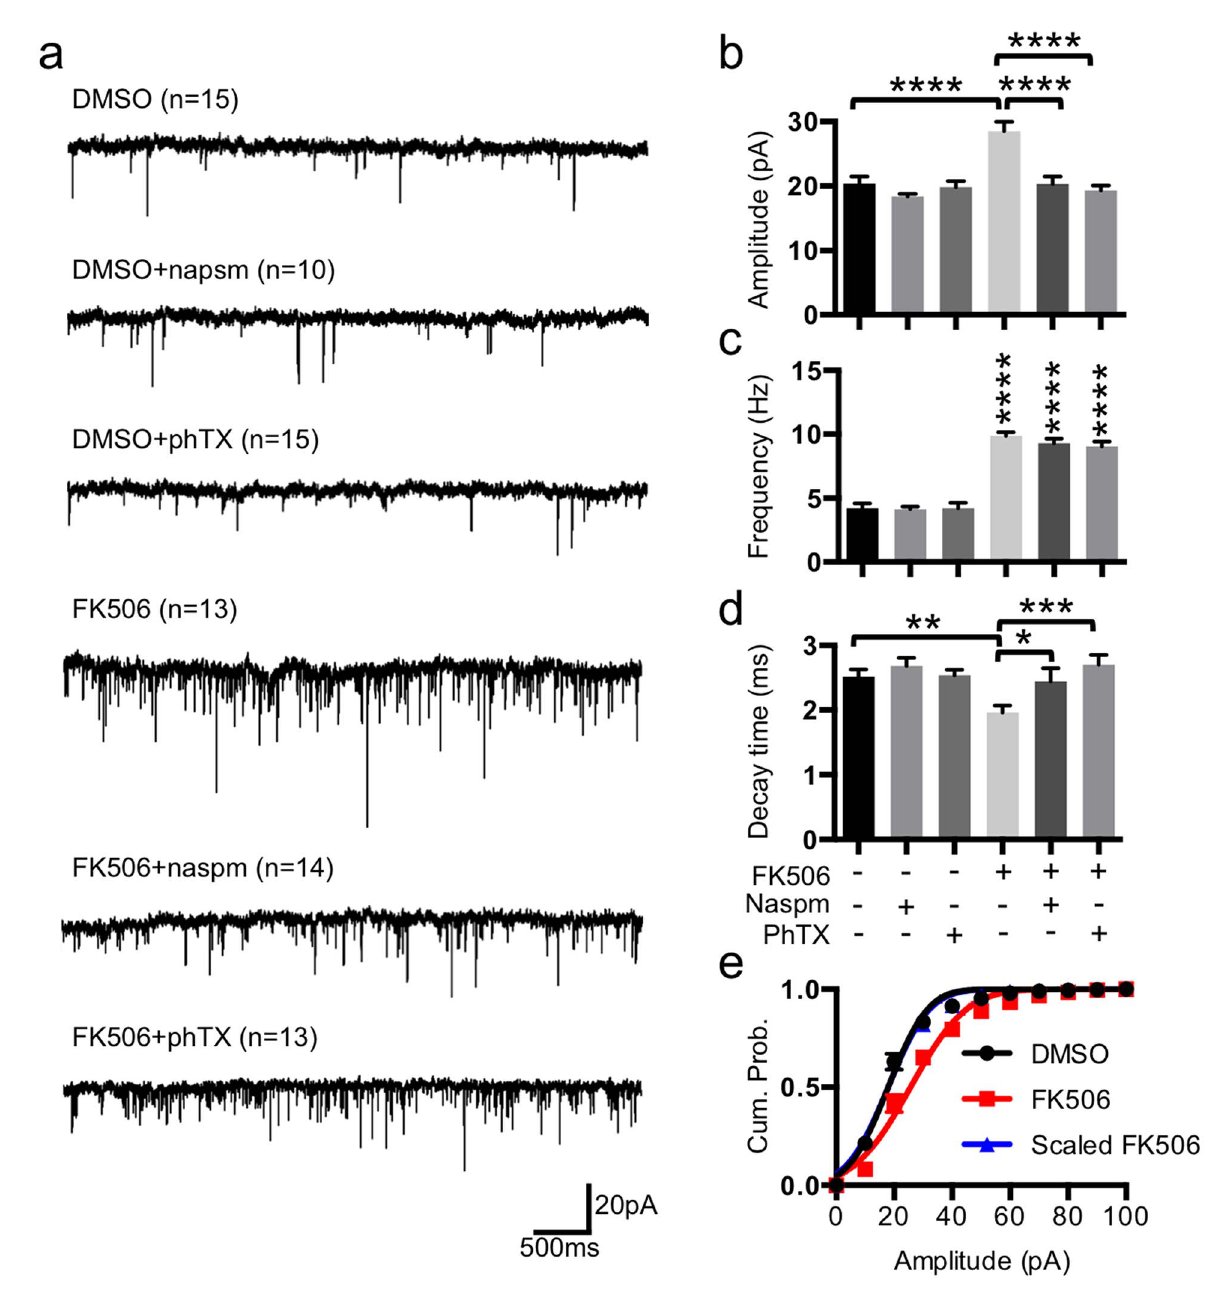
Figure 4. Inhibition of calcineurin activity induced a multiplicative pharmacologic form of synaptic scaling mediated by CPARs. (a) Representative traces of mEPSCs in each condition ( n =number of cells). (b) Average mEPSC amplitude (**** p , .0001, one-way ANOVA, uncorrected Fisher’s LSD). (c) Average mEPSC frequency (**** p , .0001, one-way ANOVA, uncorrected Fisher’s LSD). (d) Average decay time (peak to 10%) (* p , .05, ** p , .01, and *** p , .001, one-way ANOVA, uncorrected Fisher’s LSD). (e) Average cumulative probability of mEPSC amplitude. FK506 distribution is significantly different from DMSO ( p =.031, K-S test). Distribution of FK506 scaled down by a factor of 1.44 fitted to DMSO distribution ( p =.984, K-S